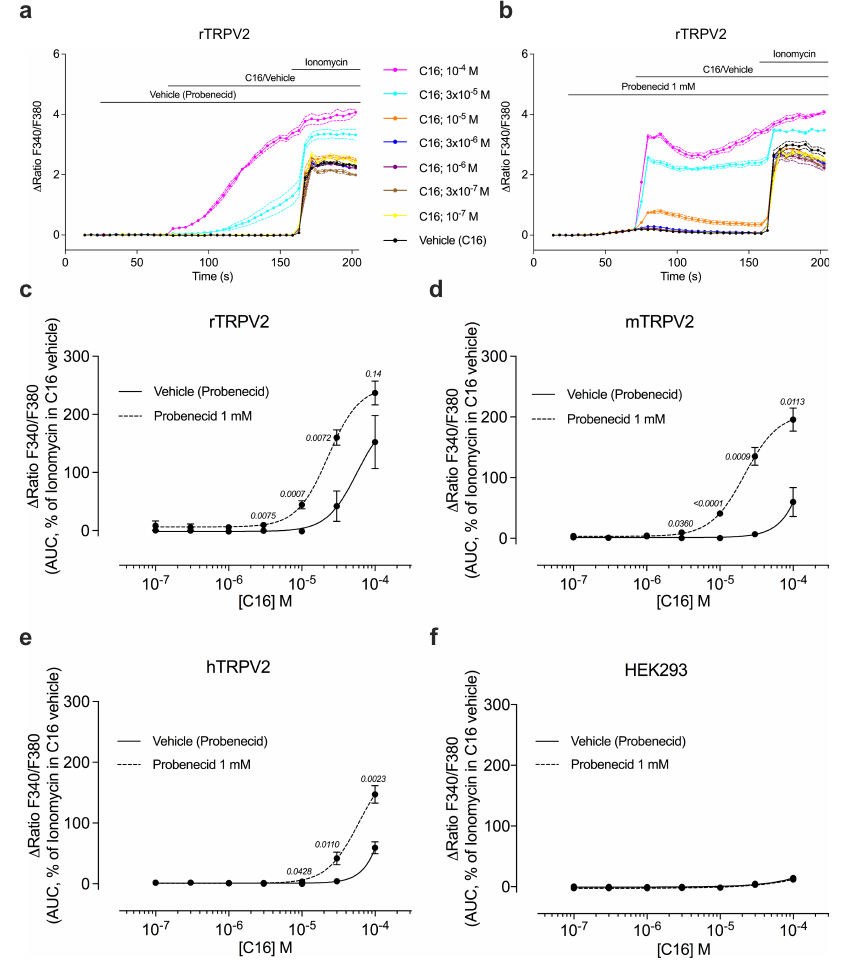
Fig. 1 | C16 evoked TRPV2 responses are ampli fi ed by probenecid. Probenecid (Prob, 1mM), but not its vehicle, sensitized rat ( a - c ), mouse ( d ) and human ( e ) TRPV2-expressing HEK293T cells to the cannabinoid Δ 9 -tetrahydrocannabiorcol (C16) but not its vehicle. No ampli fi cation of C16 responses was observed in untransfected HEK293Tcells ( f ).Data are shown as means±SEMfrom three ( d ) to four ( c , e and f ) separate experiments, each performed in triplicates. The experi- mentswereperformed asshown in a and b with shared legends,whereionomycin